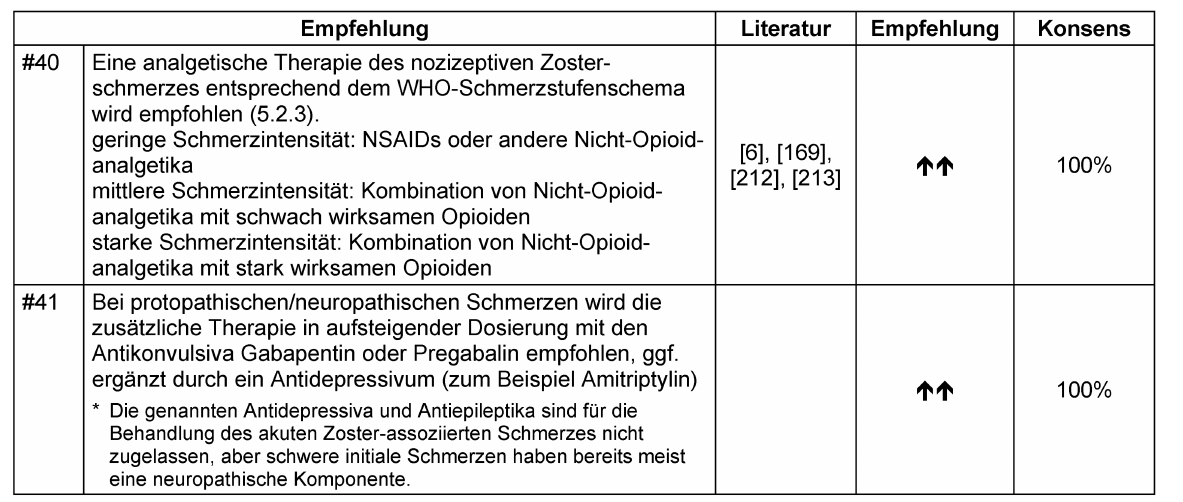
Tabelle 29: Empfehlungen zur Schmerzbehandlung bei Zoster; Empfehlung #40 und